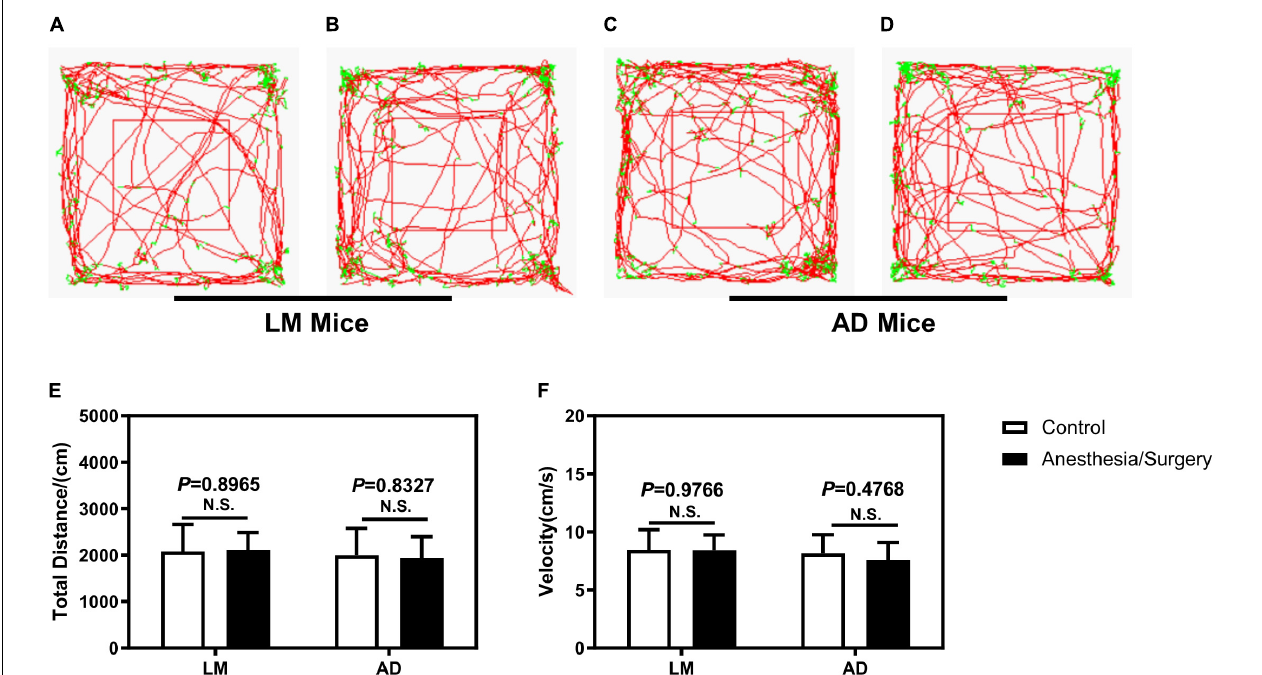
FIGURE 2 | The effect of anesthesia and surgery on the locomotor activity of LM mice and 5XFAD Tg mice. The movement trajectory (A–D) , total distance (E) , and velocity (F) of LM mice and 5XFAD Tg mice in the control and anesthesia/surgery groups. The movement trajectory of LM mice and 5XFAD Tg mice were both evenly distributed, and no difference was found in the total distance and velocity of LM mice and 5XFAD Tg mice between the control and anesthesia/surgery groups. Results are expressed as mean ± SEM, n = 12. Student t -test. N.S., P > 0.05 vs. untreated controls.